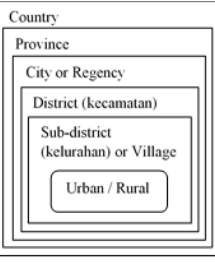
Figure 3. Hierarchy level in